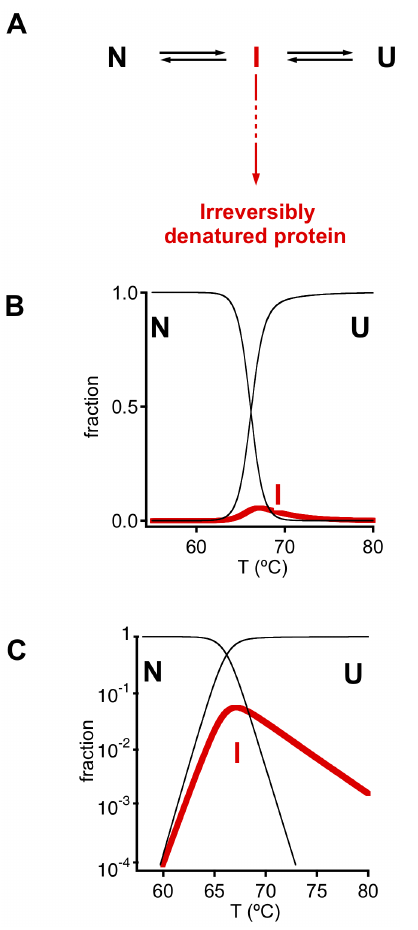
Figure 8. Model used to derive equation 3 and describe the experimental thermal inactivation profiles for wild-type phy- tase and variants (Figures 7A and B). (A) An intermediate state (or ensemble) is assumed to be critical for the irreversible denaturation process. (B) and (C) At equilibrium, the population of I is always low, although it reaches a maximum roughly within the temperature range of the transition. When using a logarithmic scale (panel C) the shape of the population of I versus temperature profiles matches that of the ln( t 1/2 ) versus temperature plots of Figure 7, with the maximum of population of I corresponding to the minimum of t 1/2 (see equation 3 ). The profiles in panels B and C have been calculated using equations provided in Text